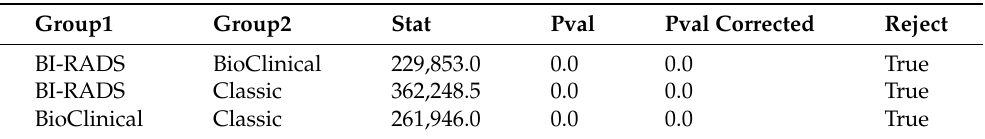
Table A9. Bonferonni-corrected Mann–Whitney U test results for section segmentation with auxiliary data in an ablation study with 10% of training data.